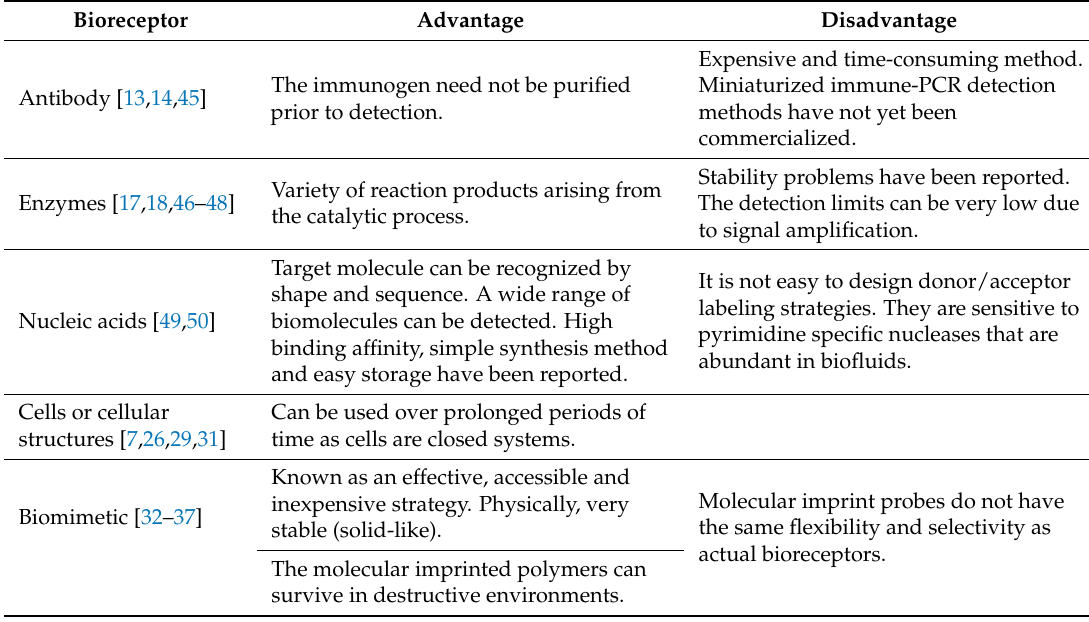
Figure 3. The molecular imprinting method for biosensor fabrication is performed by polymerization of biosystem molecules and monomer(s) mixtures including a high concentration of a crosslinking agent. Following polymerization and extraction of molecules, molecular holes are employed as complementary sites for the biosystem’s selected molecule. Table 1. Advantages and disadvantages of different bioreceptors for hydrogel based biosensors.